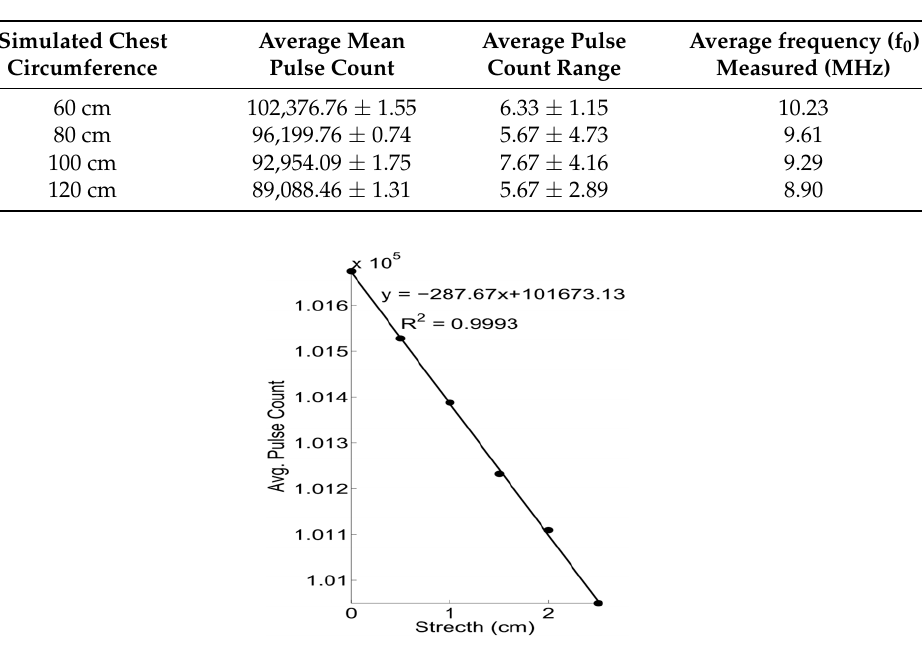
Figure 15. Results of the RIP linearity test with R 2 statistics.